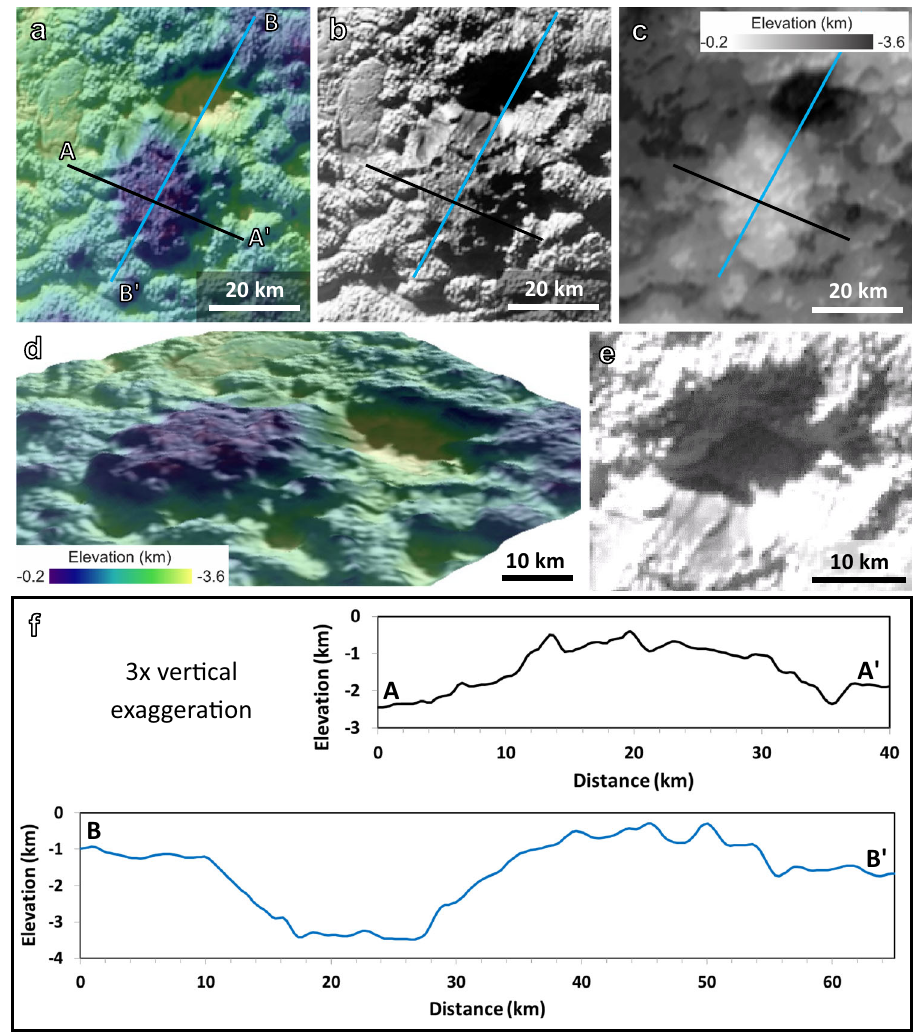
Fig. 4 Smaller dome-like feature named Coleman mons. a Topography 36 overlain on base image of feature, b , base image alone, c , topography alone, d , perspective view of dome and pit with no vertical exaggeration, e , view inside the pit, f , topographic pro fi les as shown in panels a-c, with ~3× vertical exaggeration. All images from the New Horizons observation PEMV_P_MVIC_LORRI_CA (315 m px − 1 ; see Supplementary Table 1), shown in a simple cylindrical projection. The location of this feature is indicated by the letter “ D ” in Fig.